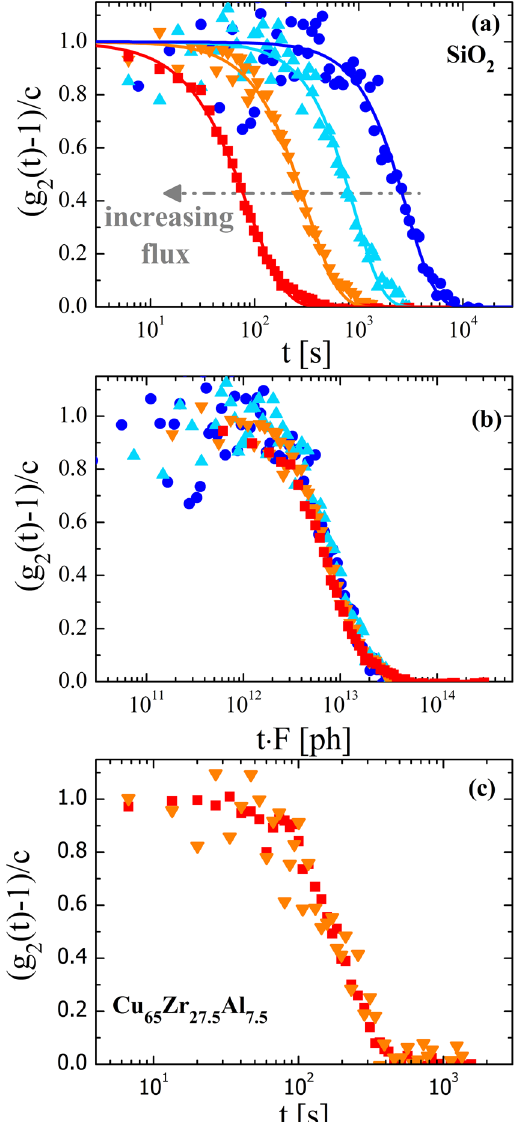
Figure 1. Relaxation dynamics of the atoms as a function of the incident X-ray beam intensity. ( a ) Normalized intensity auto-correlation functions measured in vitreous silica at T = 295 K and wave-vector Q p = 1.5 Å − 1 for different intensities of the flux of the X-ray beam. From left to right: F 0 ≈ 1 · 10 11 ph/s (red squares), F 1 ≈ 3 · 10 10 ph/s (orange down-triangles), F 2 ≈ 1.2 · 10 10 ph/s (cyan up-triangles) and F 3 ≈ 3.6 · 10 9 ph/s (blue circles). Lines are fits with a Kohlrausch-Williams-Watts function. The corresponding decay times are reported in Fig. 2d while the shape parameter β is found to be ~1.4 ± 0.1, independent on the incoming flux. ( b ) Same data rescaled by the incoming flux. ( c ) Normalized intensity auto-correlation functions measured in Cu 65 Zr 27.5 Al 7.5 metallic glass at T = 413 K and Q p = 2.5 Å − 1 for F 0 ≈ 1 · 10 11 ph/s (red squares), and F 1 ≈ 3 · 10 1 ph/s (orange